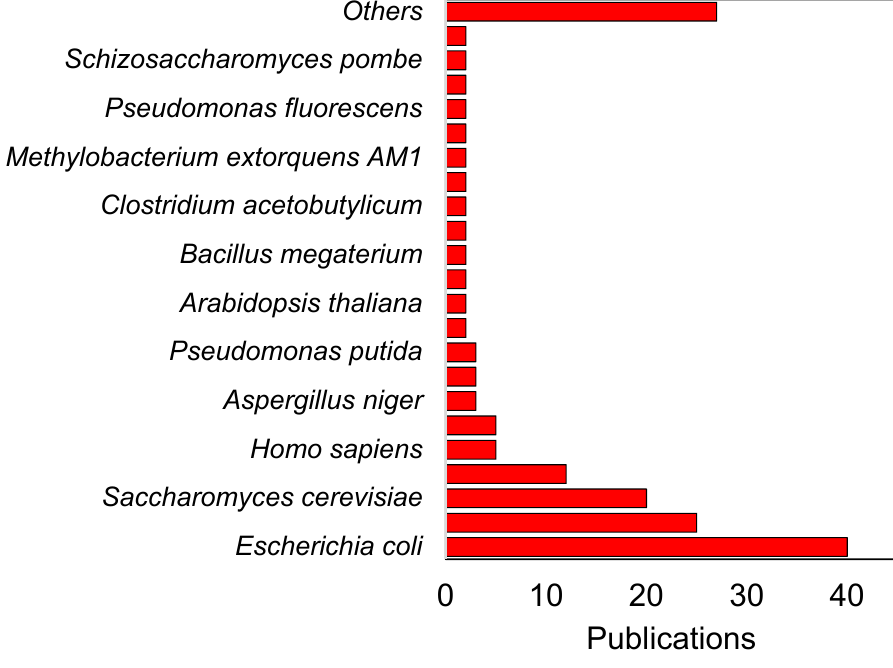
Figure 2. Summary of current 13 C-MFA studies on different Figure 2 . Summary of current 13 C-MFA studies on different organisms.